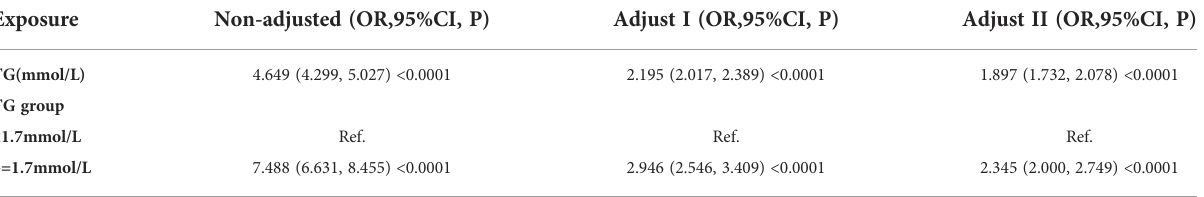
TABLE 5 Relationship between TG and NAFLD in different models. Exposure